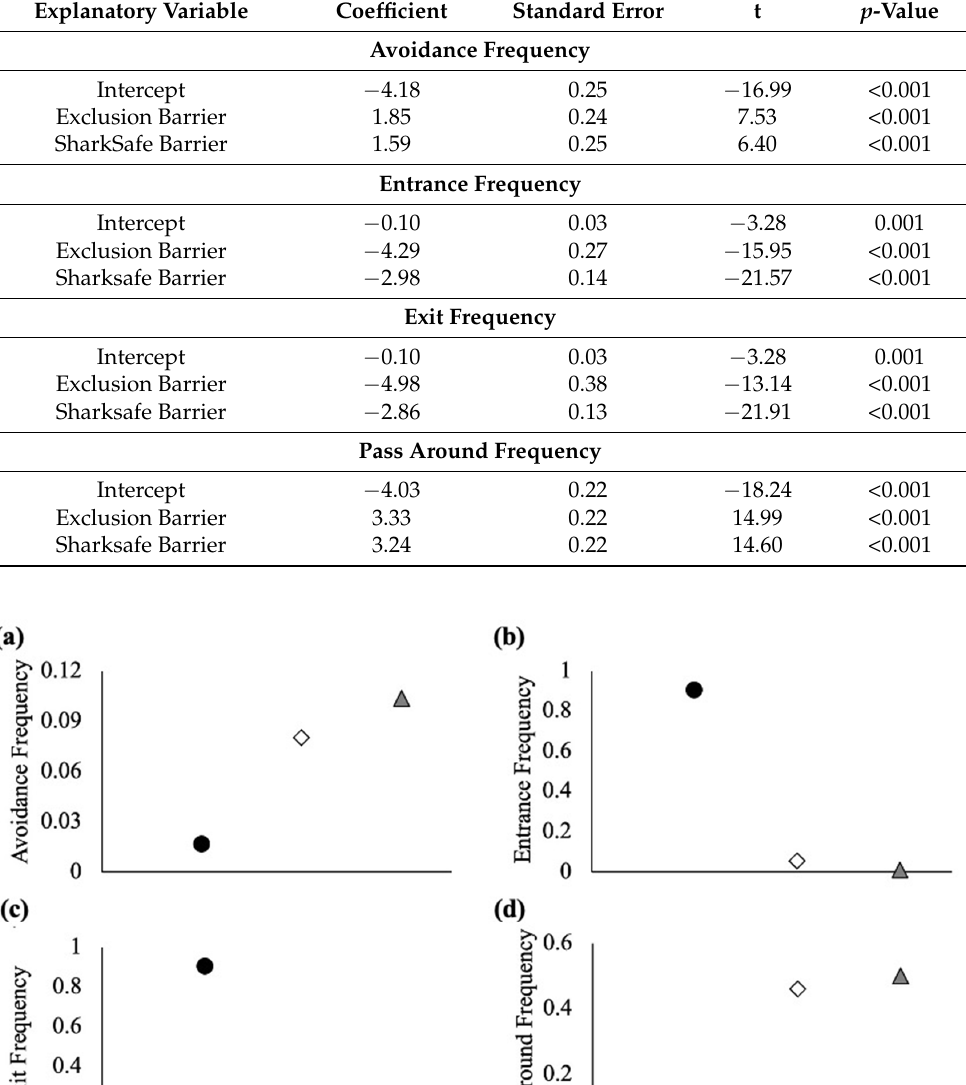
Table 3. Coefficients, standard errors, t statistic and p-values of explanatory variables for best models A2, B2, C2, and D2 for avoidance, entrance, exit and pass around frequencies, respectively, for the bull shark ( Carcharhinus leucas ) in relation to the barrier regions.